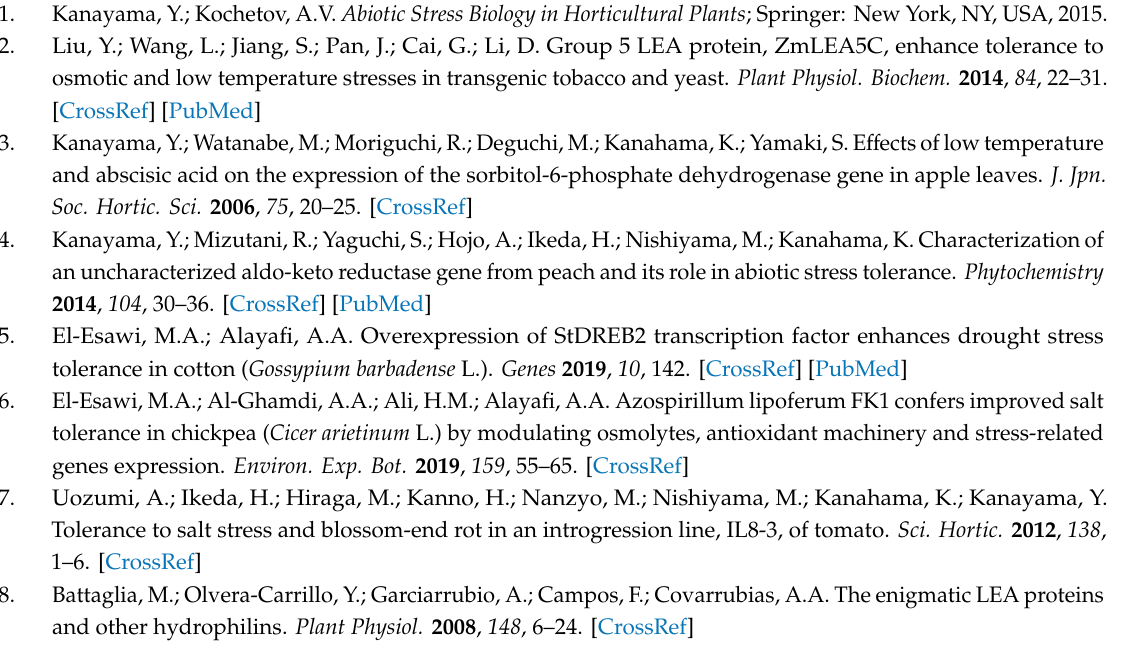
Table S1: List of primer sequences, Figure S1: mRNA levels of PcLEA14 and AtLEA14 in LOX lines of transgenic Arabidopsis expressing PcLEA14